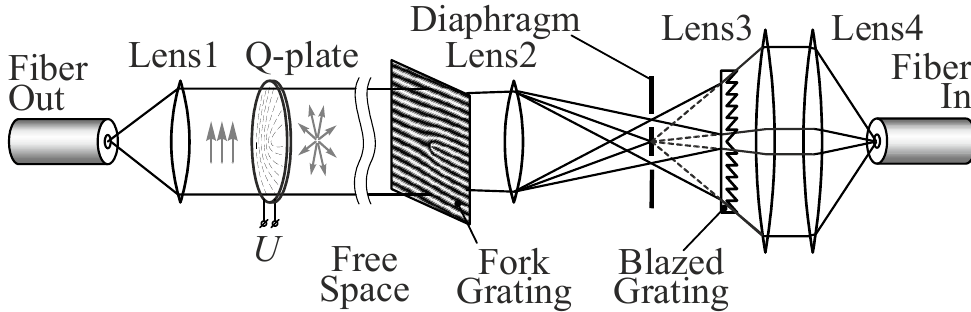
Figure 6. Schematic of an optical setup.